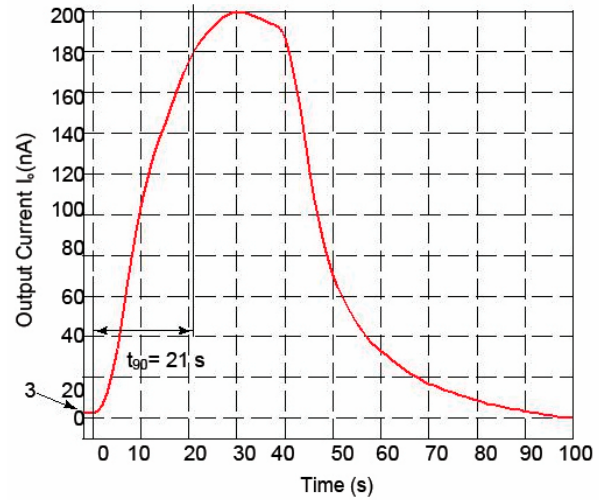
Figure 5. Output current response to 250 ppb step of H 2 S gas concentration. A response time (t 90 ), i.e.,